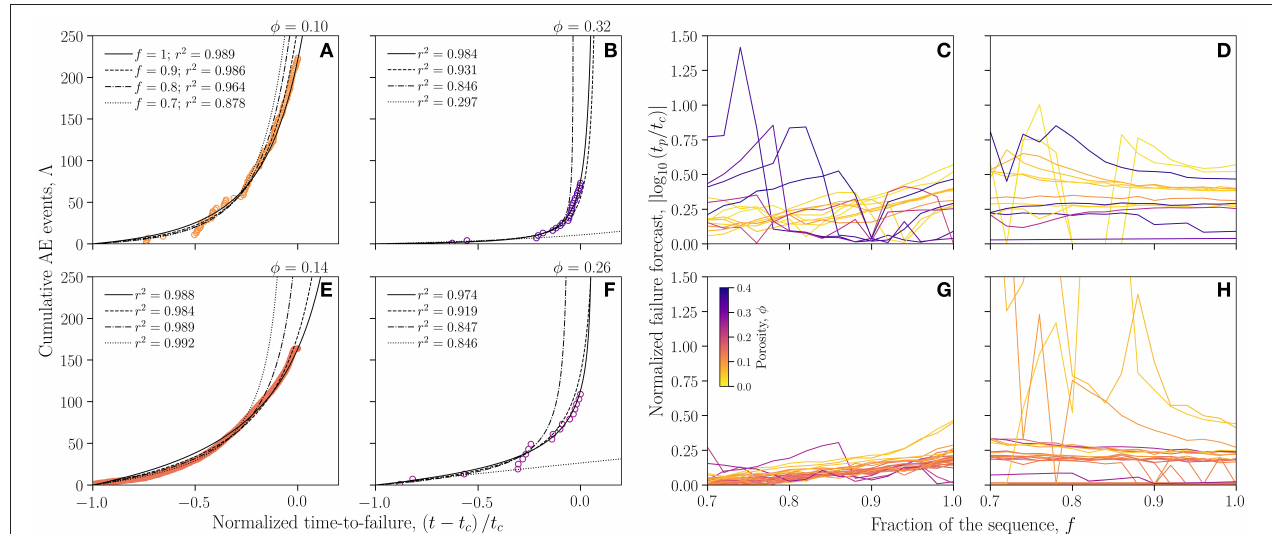
FIGURE 4 | The effect of taking different fractions of a complete dataset. (A–D) are for the synthetic variably sintered glass bead samples, while (E–H) are for the variably welded Mt Meager datasets. Panels (A,B,E,F) are the data for two porosities, for which the ML-TROL power-law model is fit using increasing fractions of the data. f 1 represents the full dataset, while f 0.7, for example, would indicate that 70% of the total data set, measured from the beginning, has been used in the = = fitting. Panels (C,G) are the effect of taking increasing fractions of the data on the failure time accuracy. Contrastingly, in panels (D,H) , the curves at f < 1 refers to a case when data at the beginning of the sequence is missing. A normalized failure forecast of unity (zero on this log axis), represents a perfect forecast. (A,B,E,F) contain information about the coefficient of determination r 2 obtained for each